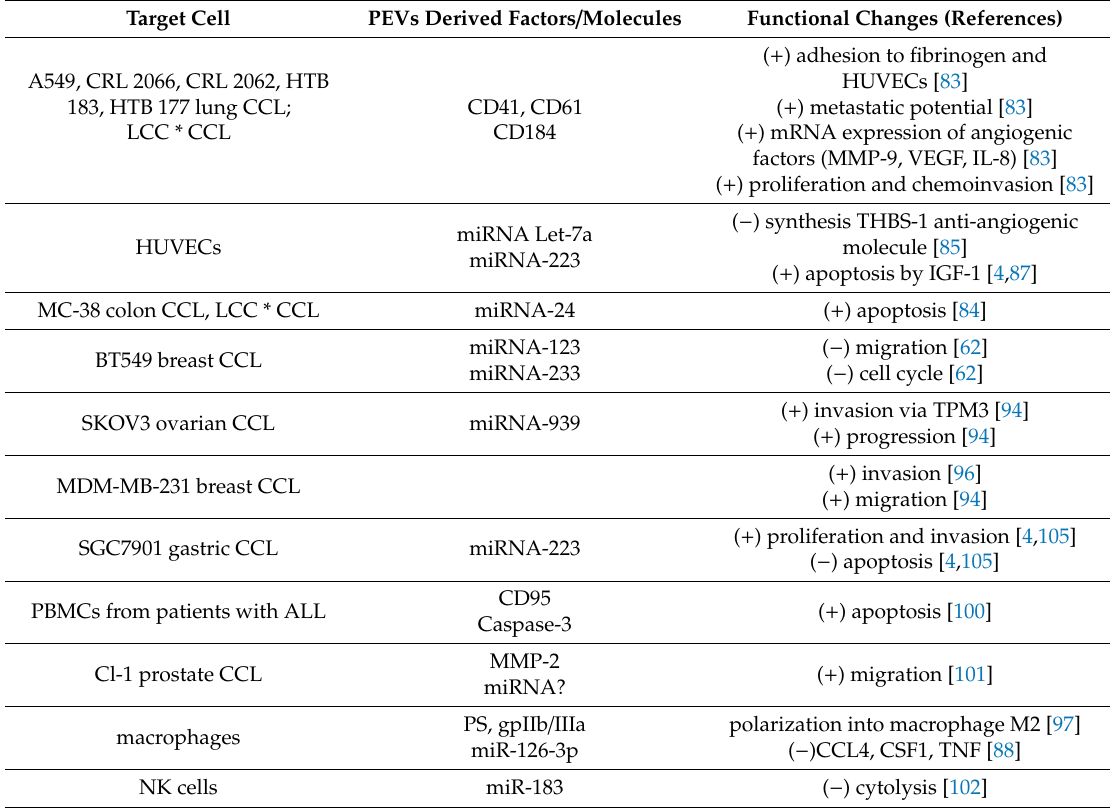
Table 2. The role of PEVs in cell-to-cell communication. PEVs secreted from activated PLTs transfer to target cells and their cargo promotes phenotypic changes and novel functions in donor